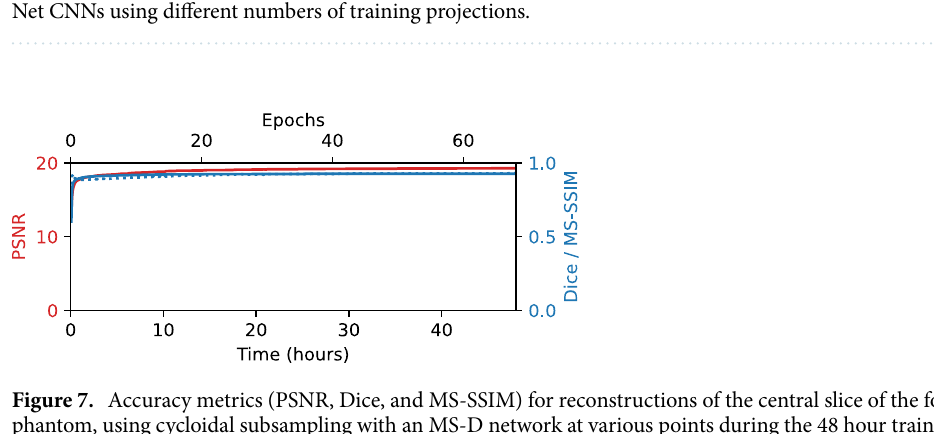
Figure 6. Quantitative comparison of images obtained after training MS-D CNNs, U-Net CNNs, and DDCM- Net CNNs using different numbers of training projections.